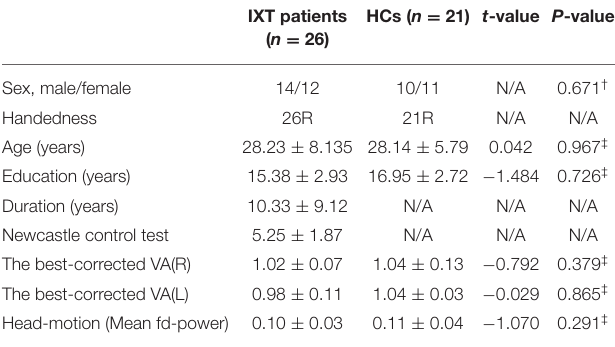
TABLE 1 | Demographics and clinical measurements of IXT patients and HCs.